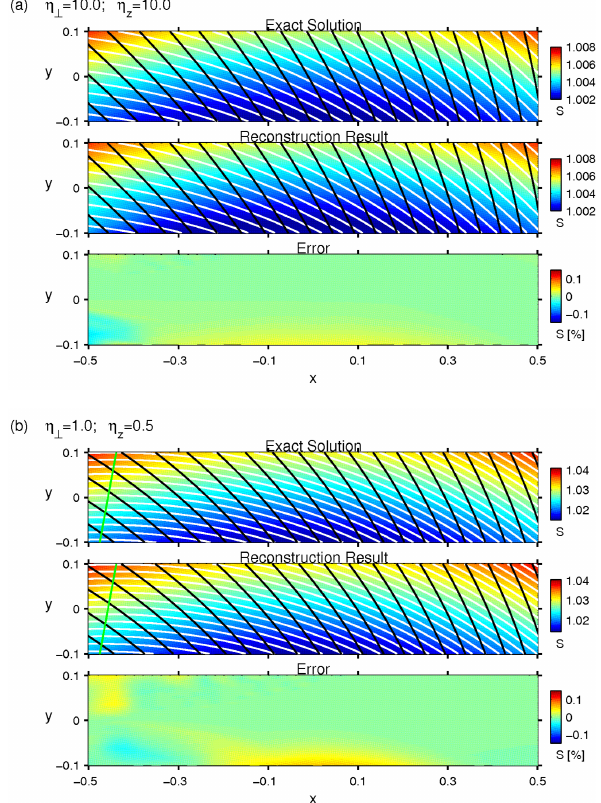
Figure 1. Comparison of exact benchmark solution with reconstruction, for (a) ˜ η ⊥ = ˜ η z = 10 . 0, and (b) ˜ η ⊥ = 1 . 0 , ˜ η z = 0 . 5. The top panel shows the overlay of the exact magnetic field lines (black) and streamlines (white) with entropy S = p/ρ γ in color, while the middle panel shows the corresponding reconstruction results. The error distribution for entropy S , expressed in percent of the average of | S | over the reconstruction window, is shown in the bottom panel. The green line on the left in the first two panels of Figure 1b indicates the locations where v y = 0.